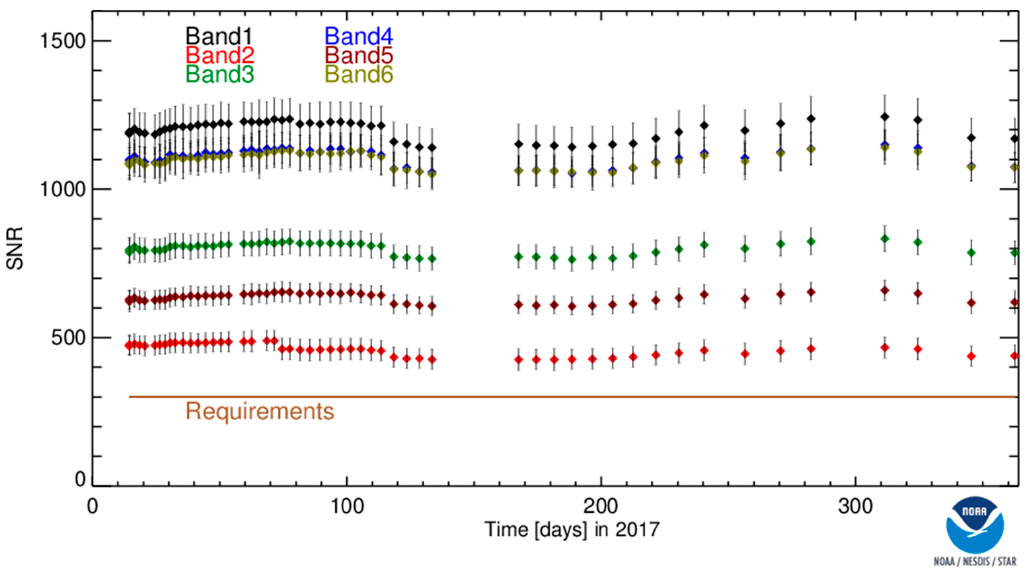
Figure 15. Time series of signal to noise ratio (SNR) for GOES-16 ABI visible and near infrared (VNIR) channels since launch (data from the Calibration Working Group, NOAA/NESDIS/STAR).